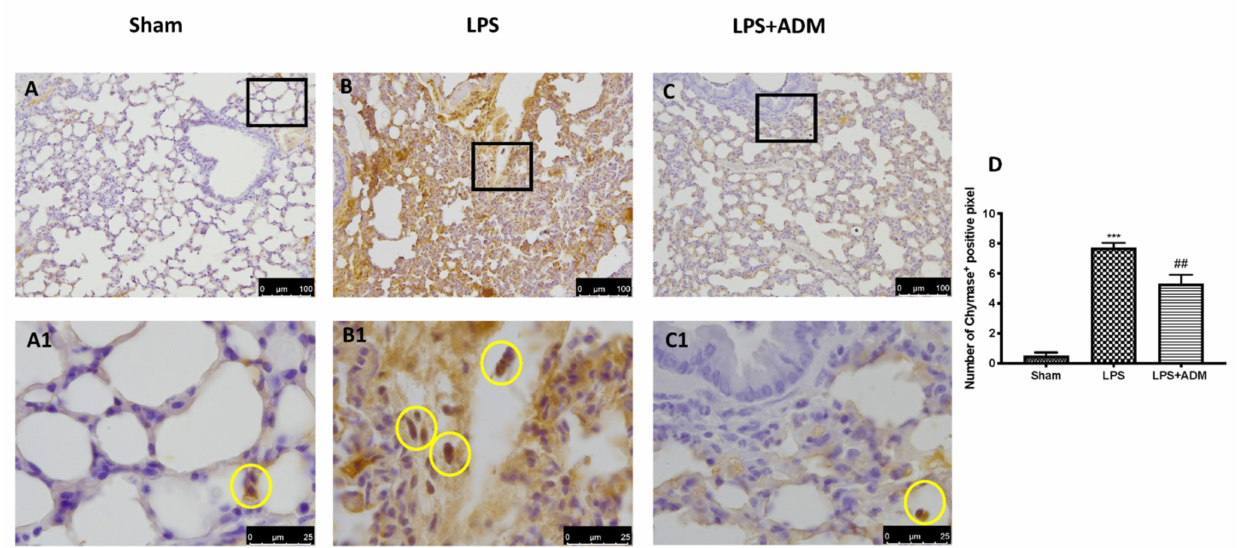
Figure 4. Immunohistochemical analysis for chymase: Sham ( A , A1 ), LPS ( B , B1 ), LPS + ADM 2% ( C , C1 ), graphical quantification ( D ). A 20 × and 100 × magnification is shown. Data are expressed as the mean ± SEM of N = 6 mice/group. *** p < 0.001 vs. sham; ## p < 0.01 vs.